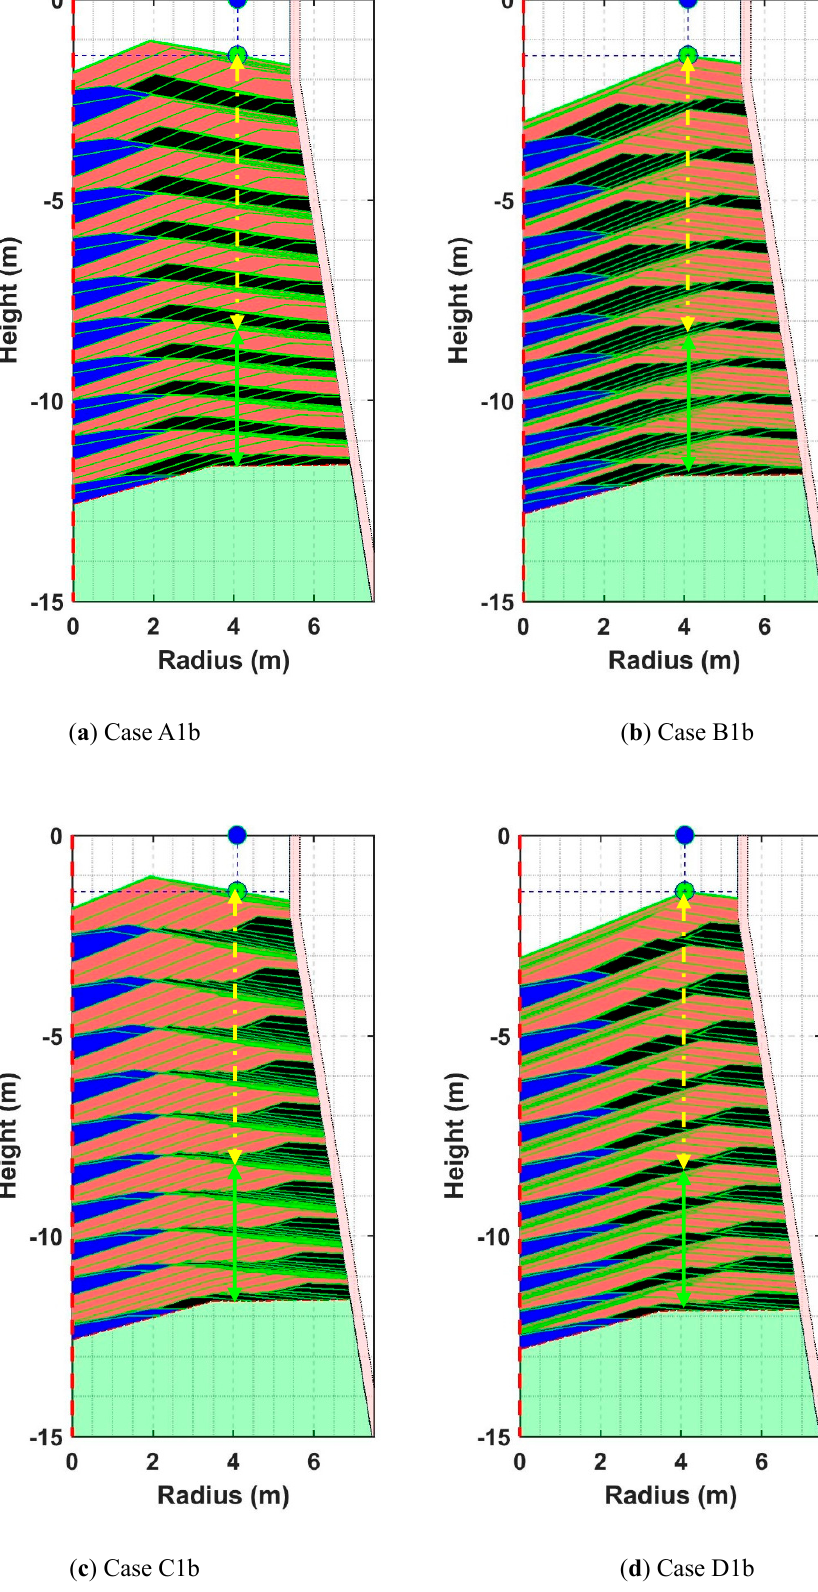
Figure 8. Evolution process of burden layer distribution in the shaft for the cases in Table 3, ( a ) Case A1b, ( b ) Case B1b, ( c ) Case C1b, and ( d ) Case D1b.